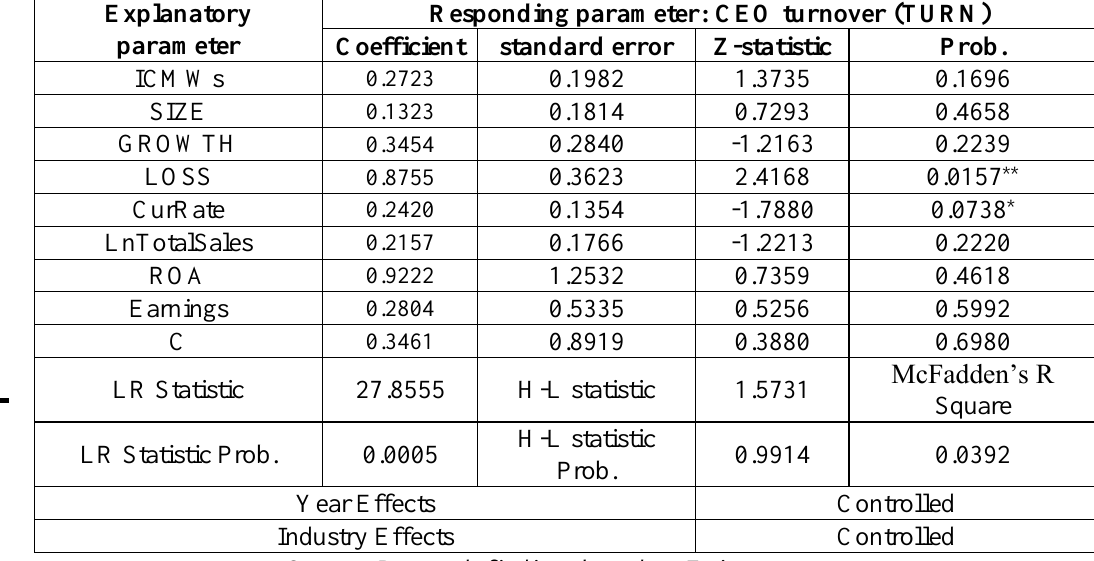
Table 3: Estimating the Logistic Model for the Primary Hypothesis Explanatory